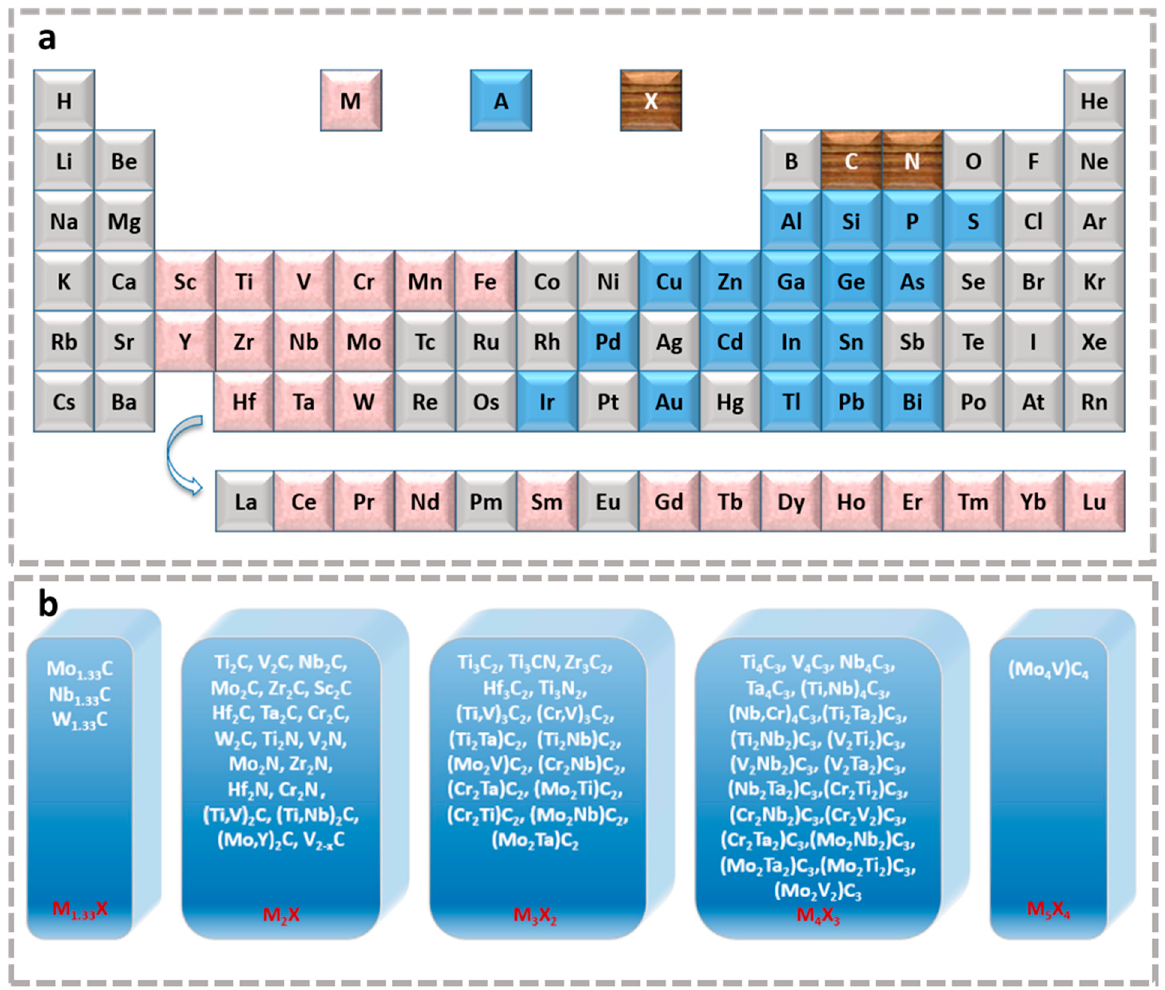
Figure 1. ( a ) Periodic table fragments marked with the “M”, “A” and “X” elements in known MAX and MXene phases. ( b ) Currently known MXene compositions, ignoring the terminal here.